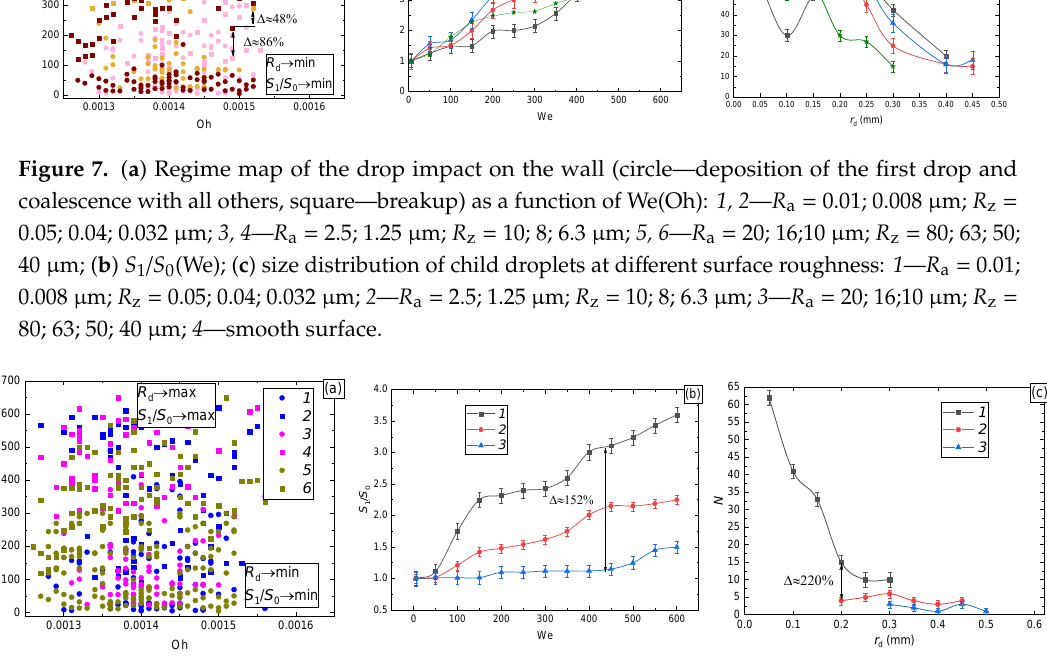
Figure 8. ( a ) Regime map of the drop impact on the wall (circle — deposition of the first drop and coalescence with all others, square — breakup) as a function of We(Oh): 1,2 — copper surface; 3,4 — surface covered by paraffin; 5,6 — surface covered by oil; ( b ) S 1 / S 0 (We); ( c ) size distribution of child droplets at We = 200 and at different wetting properties of a surface: 1 — copper surface; 2 — surface covered by paraffin; 3 — surface covered by oil